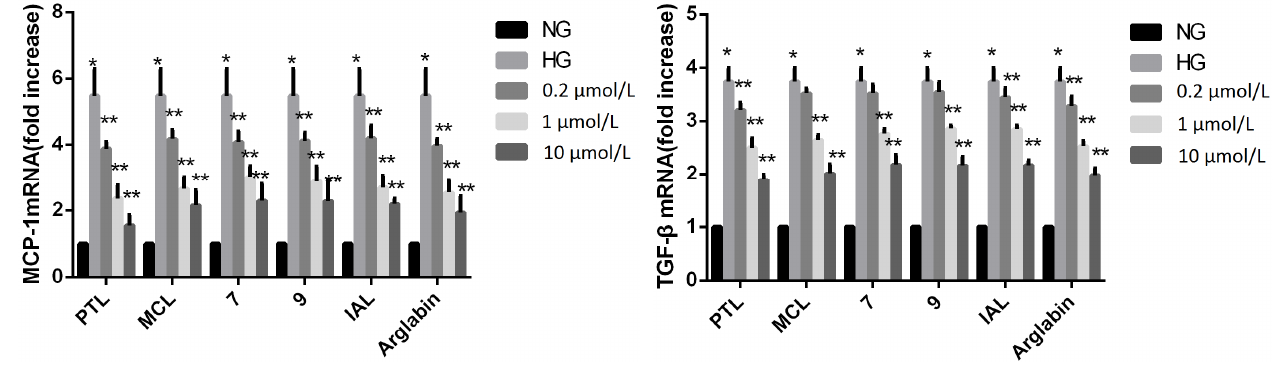
Figure 4. Effect of sesquiterpene lactones on HG-induced regulation of MCP-1 and TGF- β 1 mRNA in MCs at a concentration of 0.2, 1, 10 μ M. NG: normal glucose; HG: high glucose. * p < 0.05 vs. NG, ** p < 0.05 vs.